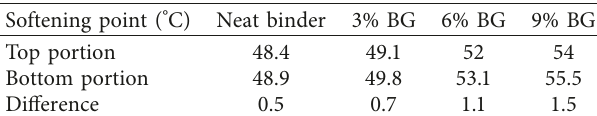
Figure 6: Ductility of bitumen with varying content of BG. Table 6: Separation index (SI) of BG-modified bitumen.